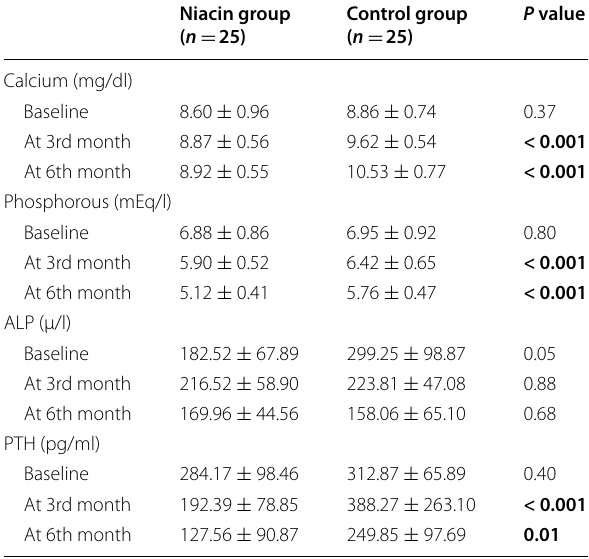
Table 5 Changes in serum electrolytes and PTH among studied patients